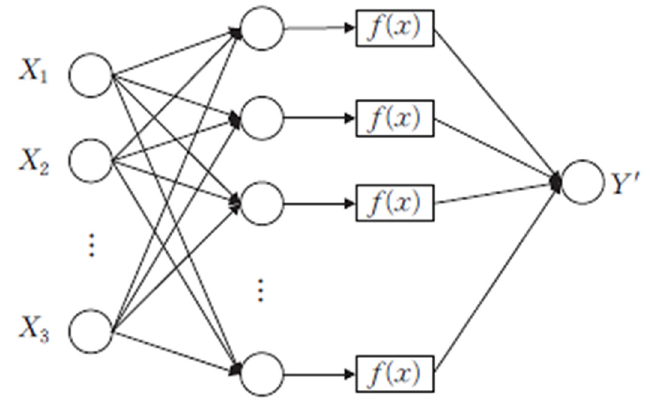
Figure 5. Illustration of BP neural network architecture.